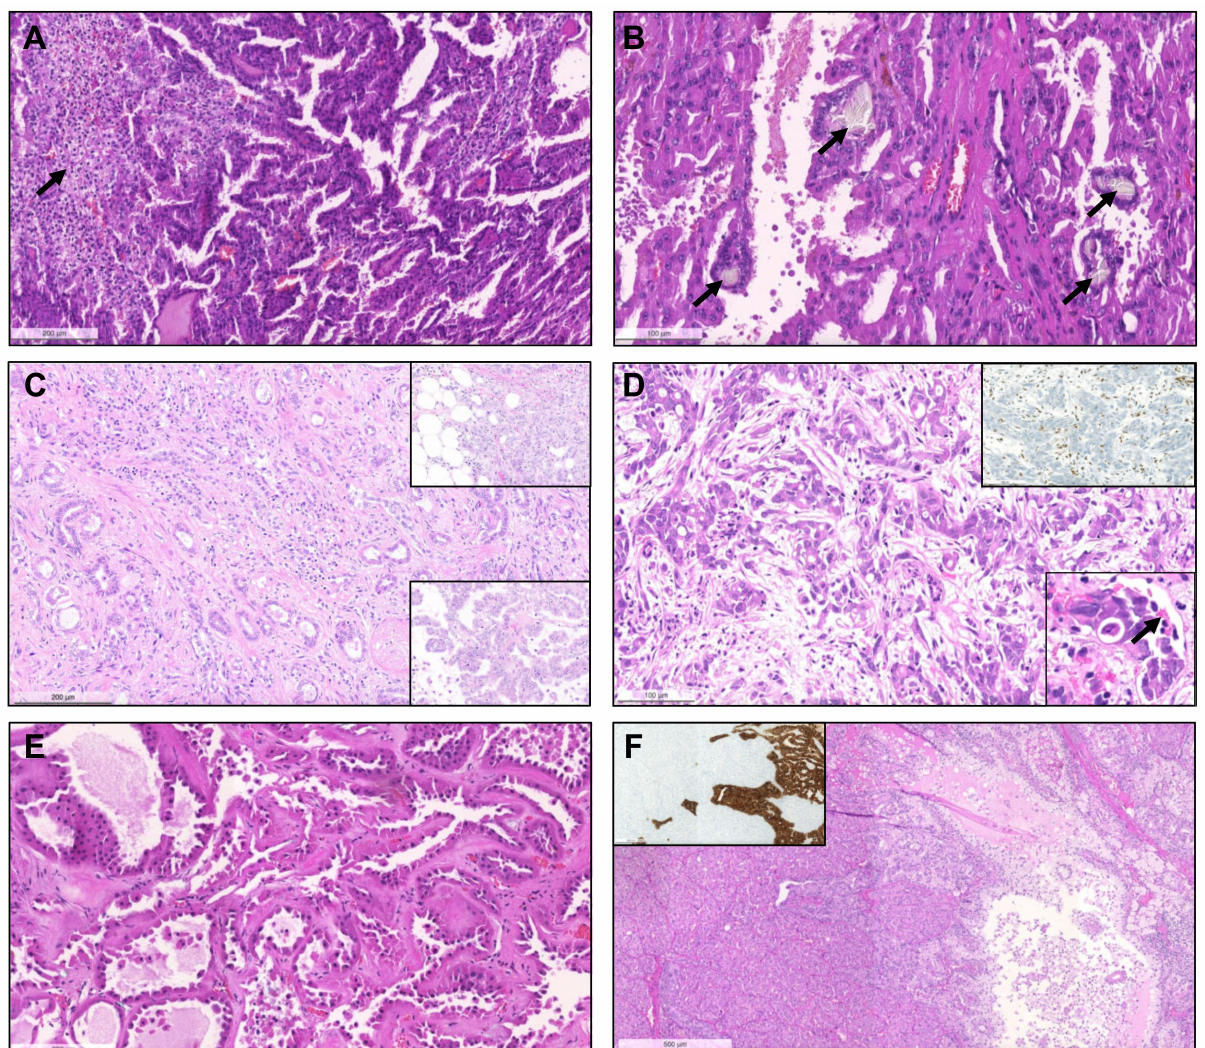
Figure 8. Acquired cystic disease-associated renal cell carcinoma, with prominent papillary fronds, intermingled with indistinct solid nodules of clear cells (( A ), arrow) and with presence of the typical oxalate calcifications (( B ), arrows). Collecting duct carcinoma, composed of highly infiltrative groups of cords and tubules disposed in a desmoplastic stroma ( C ). The tu-mor extensively infiltrated the hilar adipose tissue (inset, upper right corner). This case also showed papillary features focally (inset, lower right corner). SMARCB1 deficient medullary RCC, overlapping with collecting duct carcinoma (in-filtrative cords and tubules), with frequent angioinvasion, peritumoral neutrophils ( D ) and evidence of the characteristic sickled erythrocytes (inset, lower right corner, arrow). The tumor showed complete loss of INI1 immunoexpression (in-ternal positive control in adjacent lymphocytes and vessels). Tubulocystic renal cell carcinoma, being composed of tu-bulocystic structures filled by eosinophilic cells with prominent hobnailing and high grade nuclei, in a hypocellular fi-brotic stroma ( E ). A case of a collision tumor, with presence of a pRCC with classic morphology occurring in the middle of an oncocytoma ( F ). CK7 highlights the pRCC